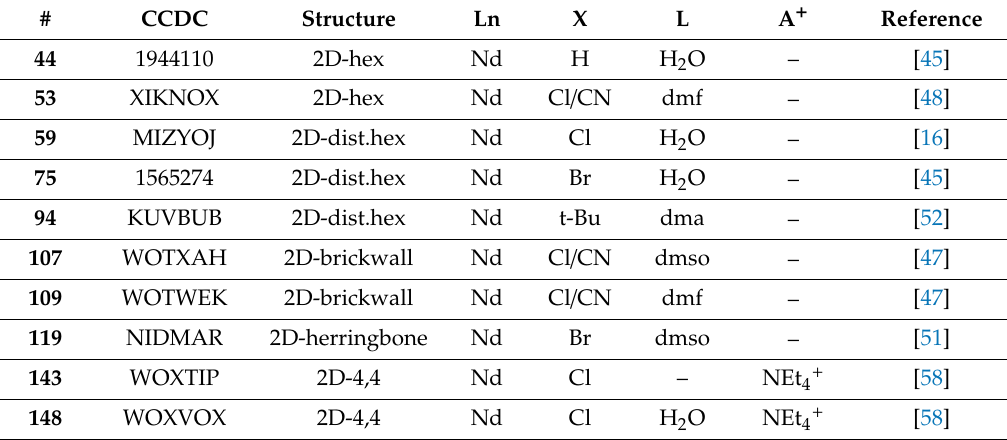
Table 17. Structurally characterized Nd(III) compounds with anilato